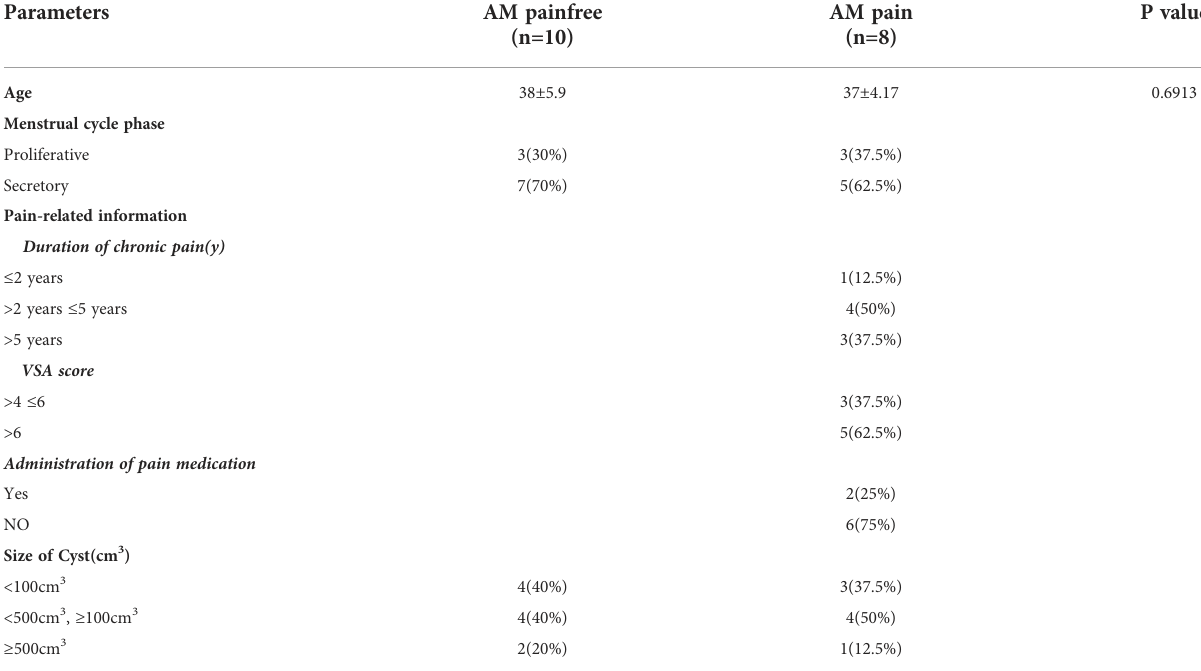
TABLE 1 Subject's Characteristics in women with and without AM pain.